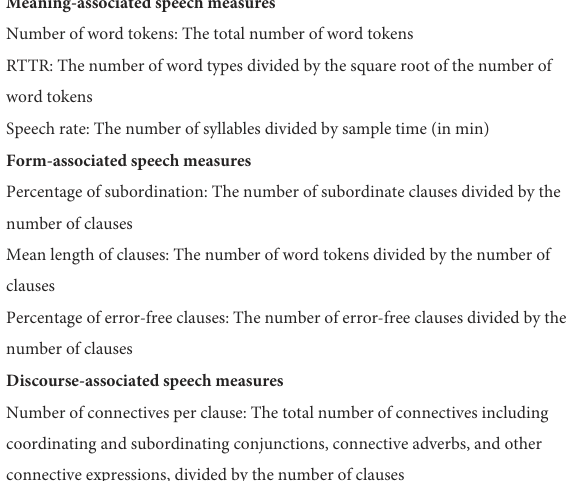
Meaning-associatedspeech